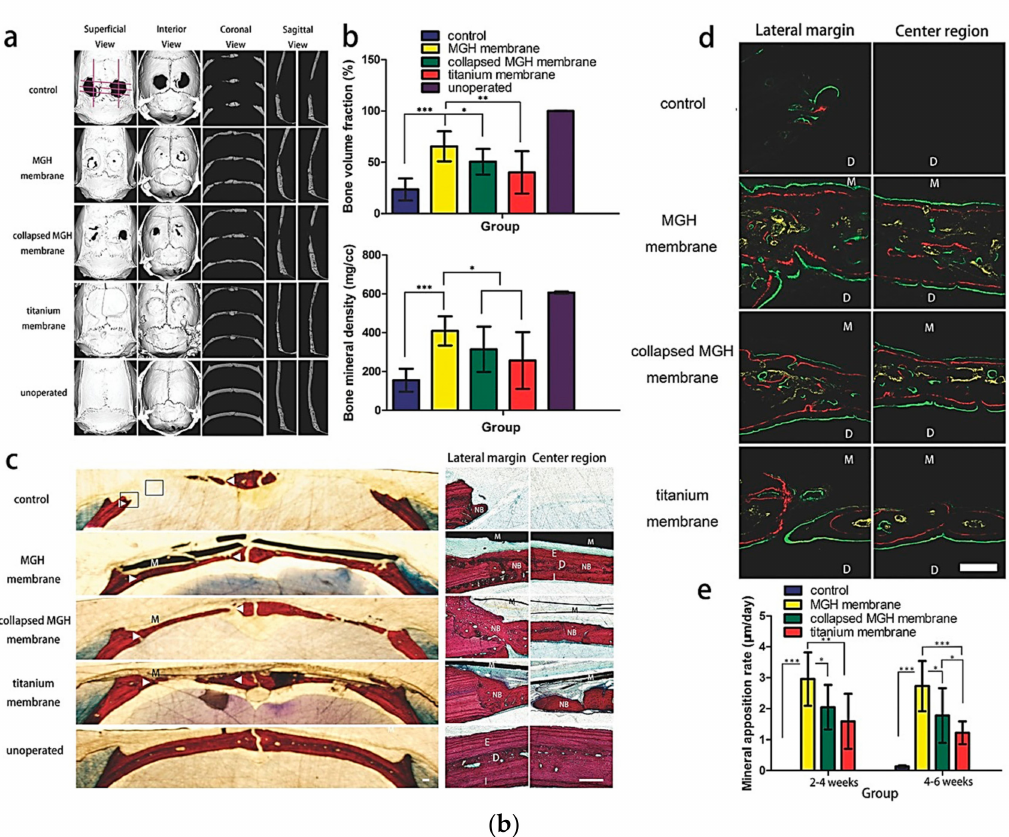
Figure 16. ( a ) Multilayered graphene hydrogel reference for bone regeneration. ( b ) Graphene